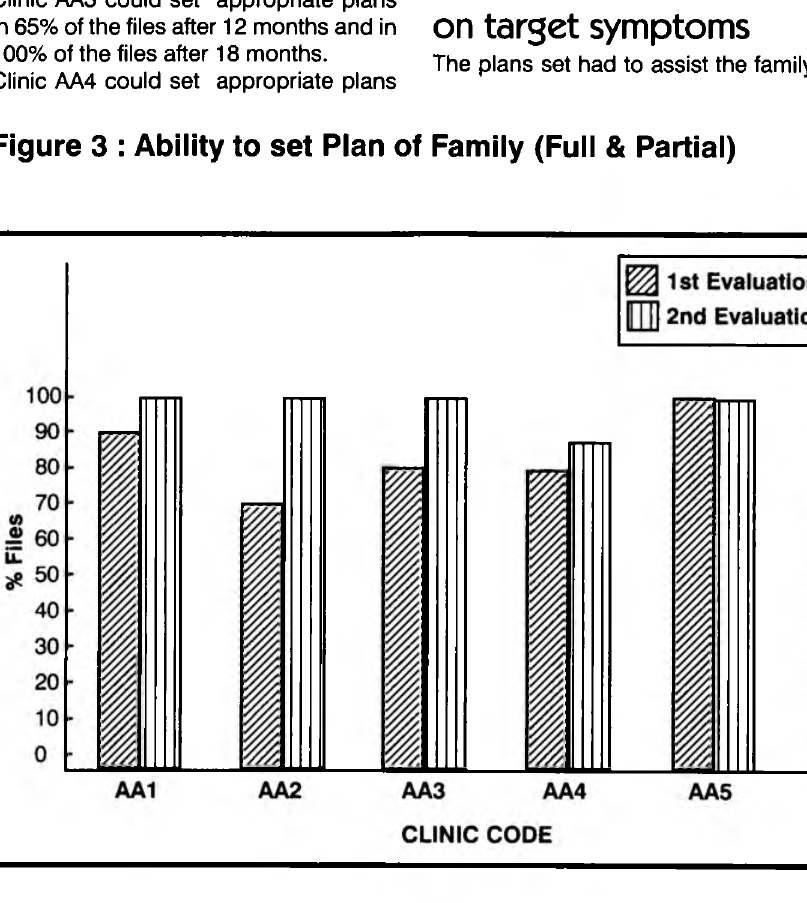
Figure 3 : Ability to set Plan of Family (Full &